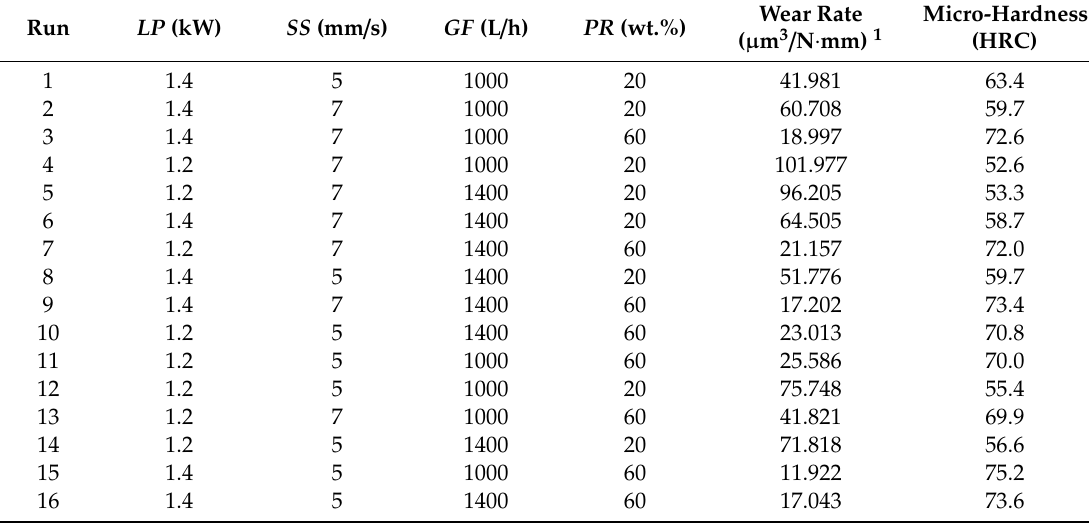
Table 4. Full factorial design and results of wear